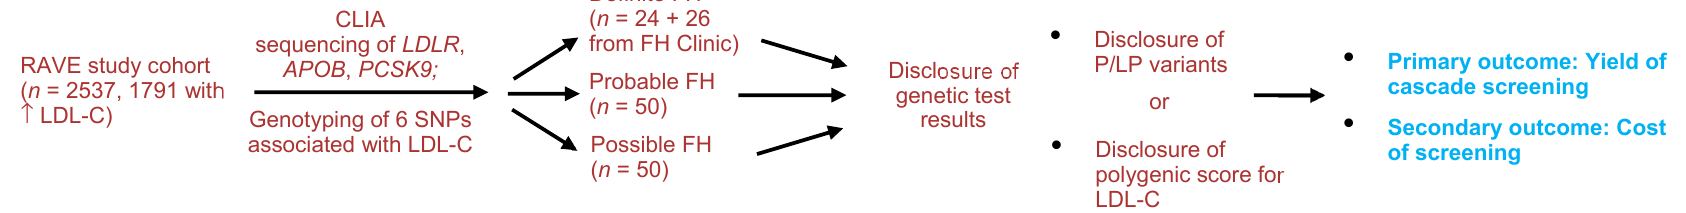
Figure 1. A flow diagram illustrating the design of the cascade screening in hypercholesterolemia (CASH) study. RAVE: return of actionable variants empiric study; LDL-C: low density lipoprotein cholesterol; CLIA: central laboratory improvement amendment; SNPs: single nucleotide polymorphisms; FH: familial hypercholesterolemia; P/LP: pathogenic/likely pathogenic; Probable FH: Dutch lipid clinic network (DLCN) score ≥ 6; Possible FH = DLCN score 3–5.